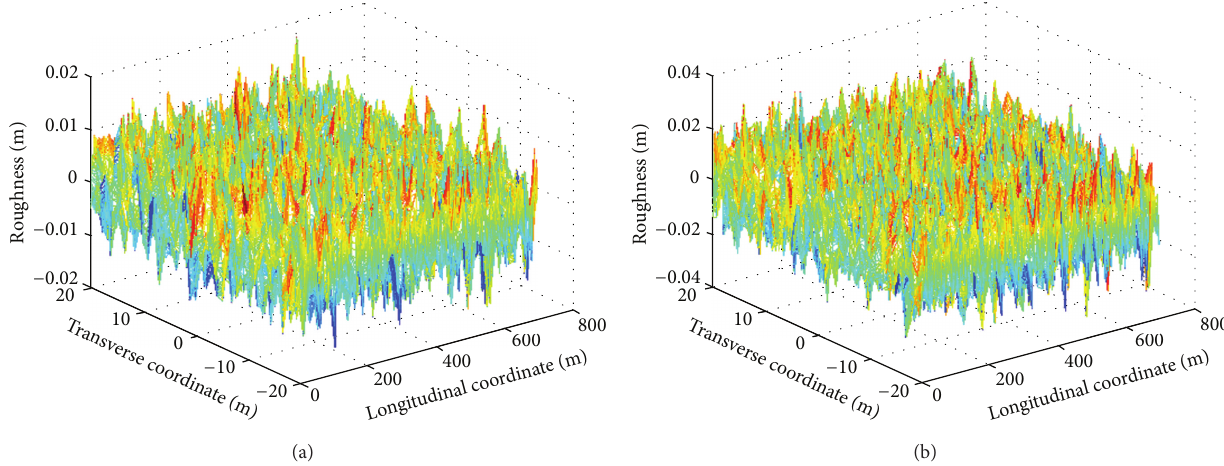
Figure 5: Multipath surface roughness: grade of roughness: (a) good; (b) average.